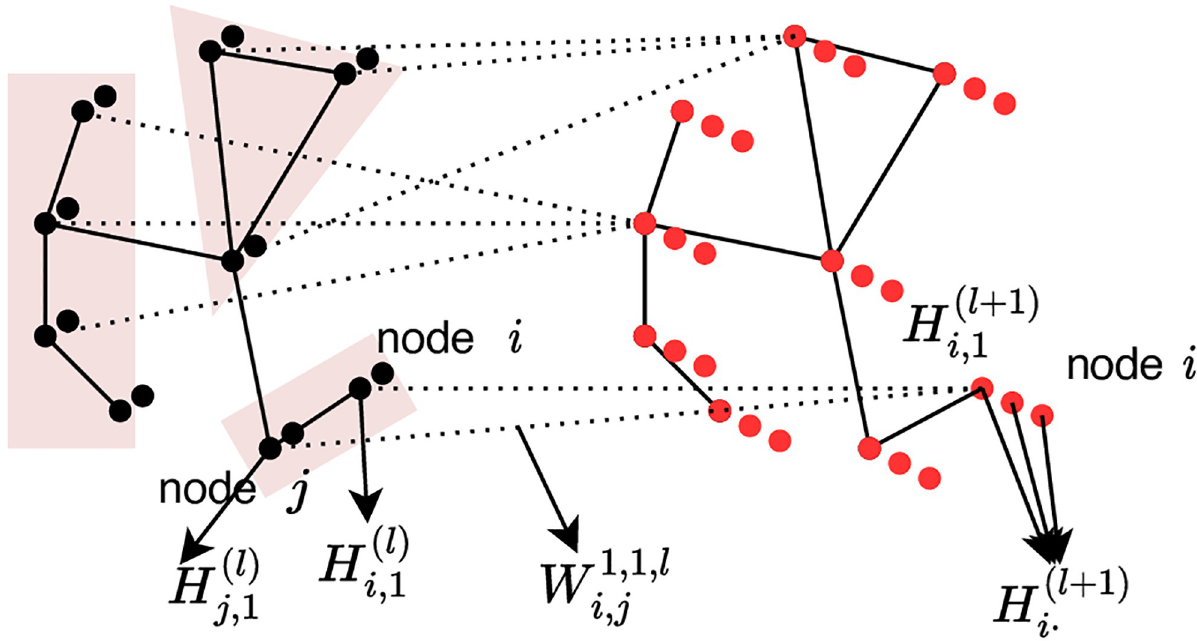
Fig 1. Detailed illustration of neighbour connection. This figure illustrates the Neighbour Connection of node i in a more detailed way. The node i has only one neighbour j . And the figure draws the linear scaling factor from the hidden feature 1 in layer l to the hidden feature 1 in layer l + 1 with respect to the node i and its neighbouring node j